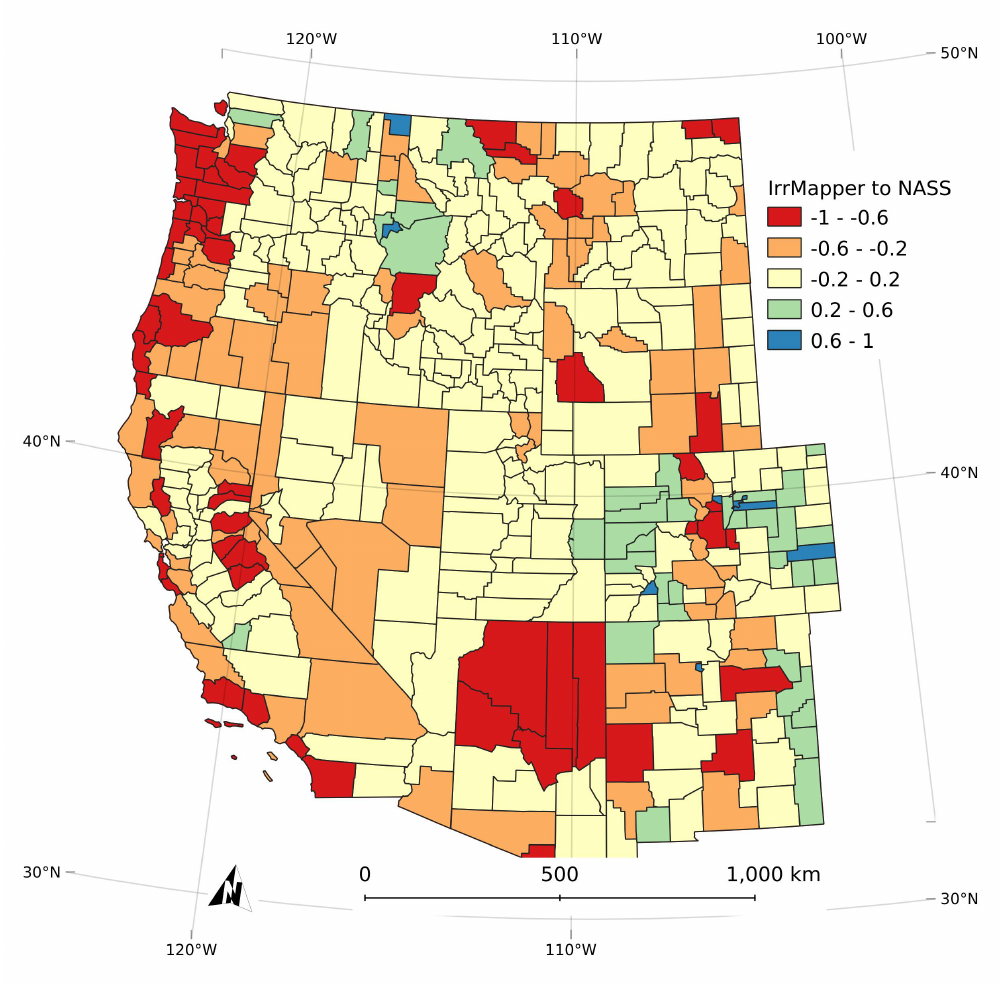
Figure 10. The normalized difference of IrrMapper and NASS county-wide Census of Agriculture mean irrigated area estimates over the years of available NASS data (i.e., 1987, 1992, 1997, 2002, 2007, 2012, and 2017). Positive values indicate where IrrMapper made larger estimates than